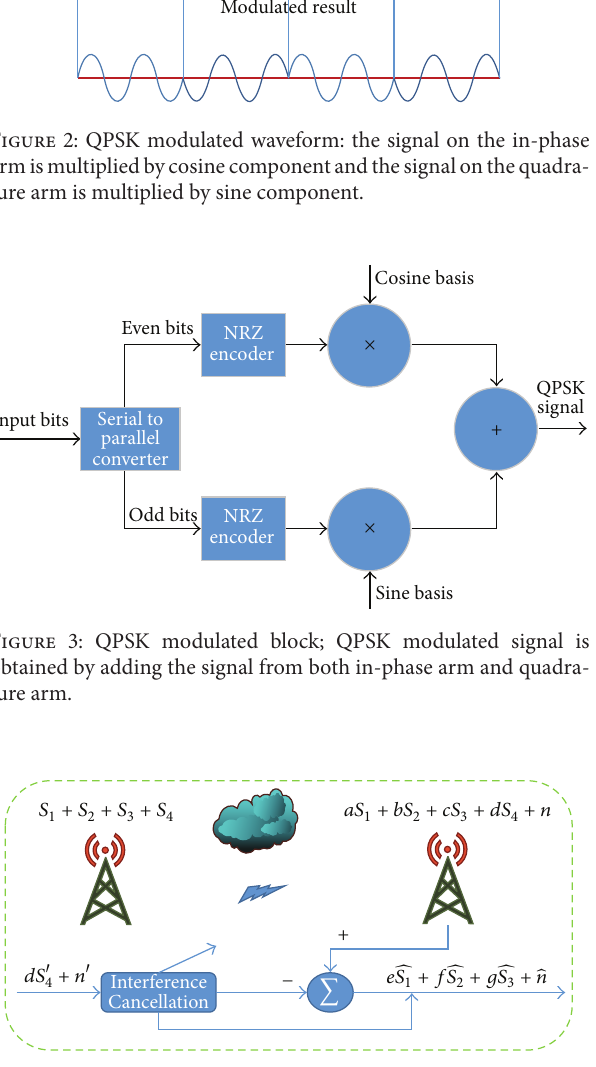
Figure 4: Framework of Interference Cancellation algorithm (IC-